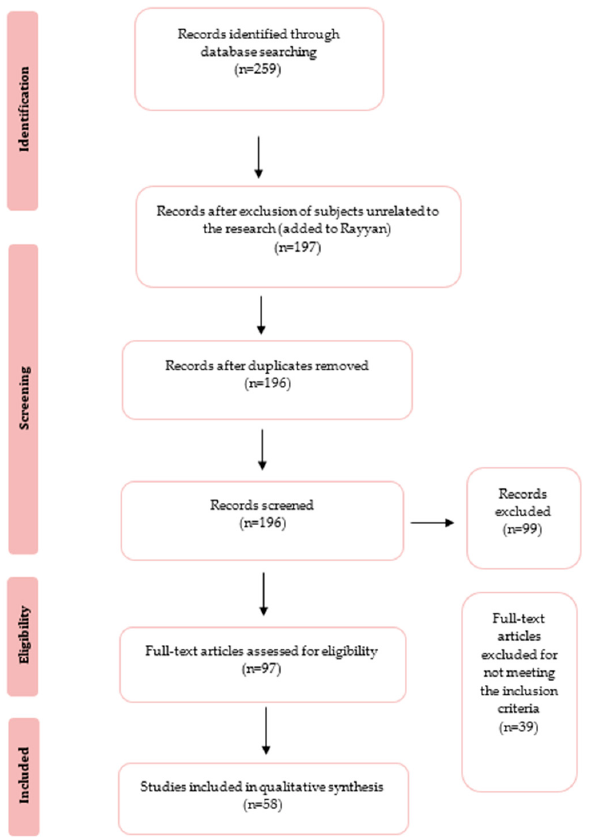
Figure 1. PRISMA-based selection of articles. Characteristics of the Selected